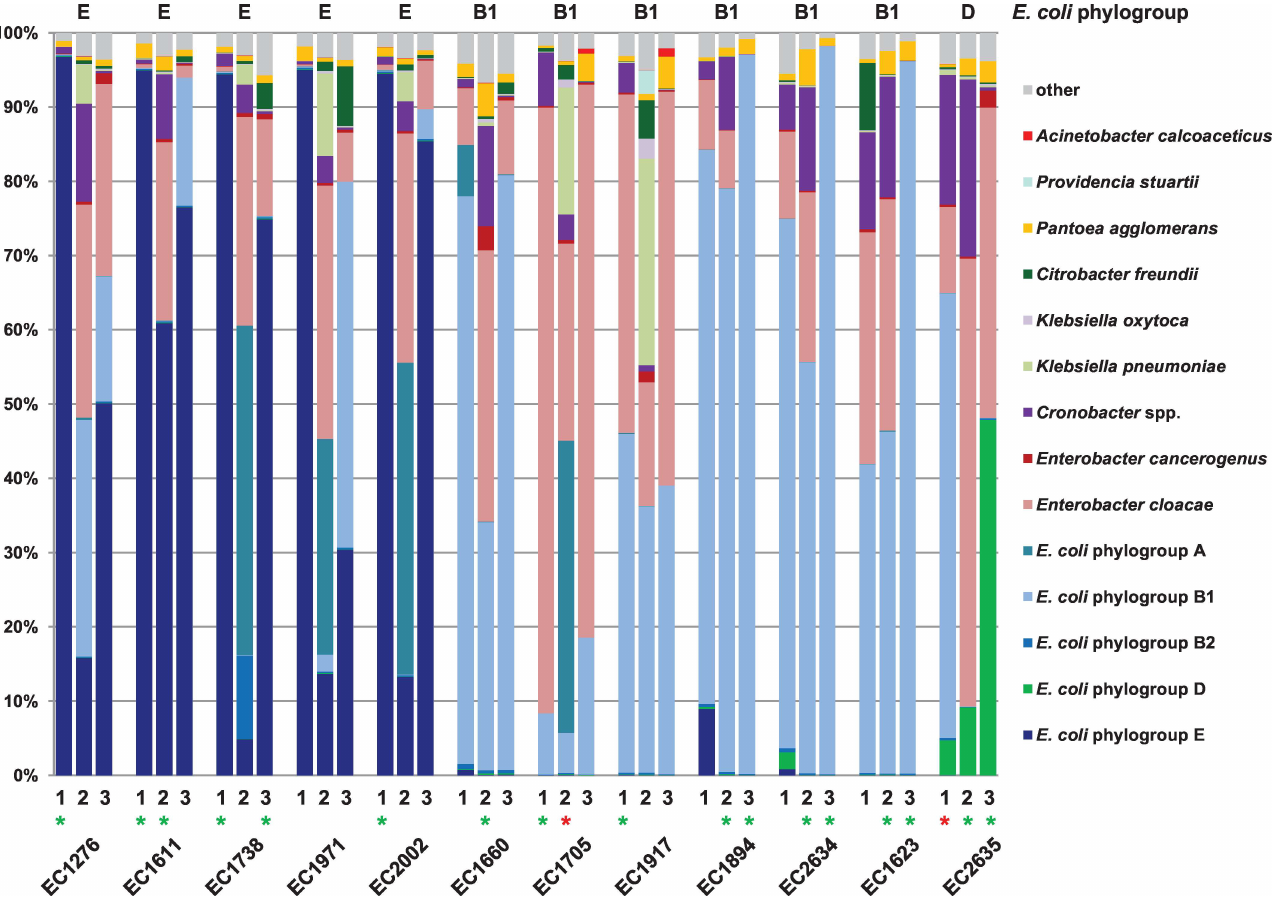
Fig 1. Microbial community associated with enriched STEC-spiked spinach. Spinachsampleswere spiked with STEC at a level of 0.1 CFU/g and enriched. Triplicate experiments for each strain were performed using baggedspinachpurchased at different times and designated m1, m2, and m3. The E . coli phylogroupof the spiked STEC strain is indicatedat the top of the figure. Bacterial generaor species contributing (cid:21) 1% to the total identified populationin at least one sample are shown and the sum of all other species identifiedin lower abundances is includedin “other”. Samples in which the serogroup of the spiked STEC was the only serogroupdetected (green asterisk) and samples for which the serotype or virulencegenes were not detected (red asterisk) are